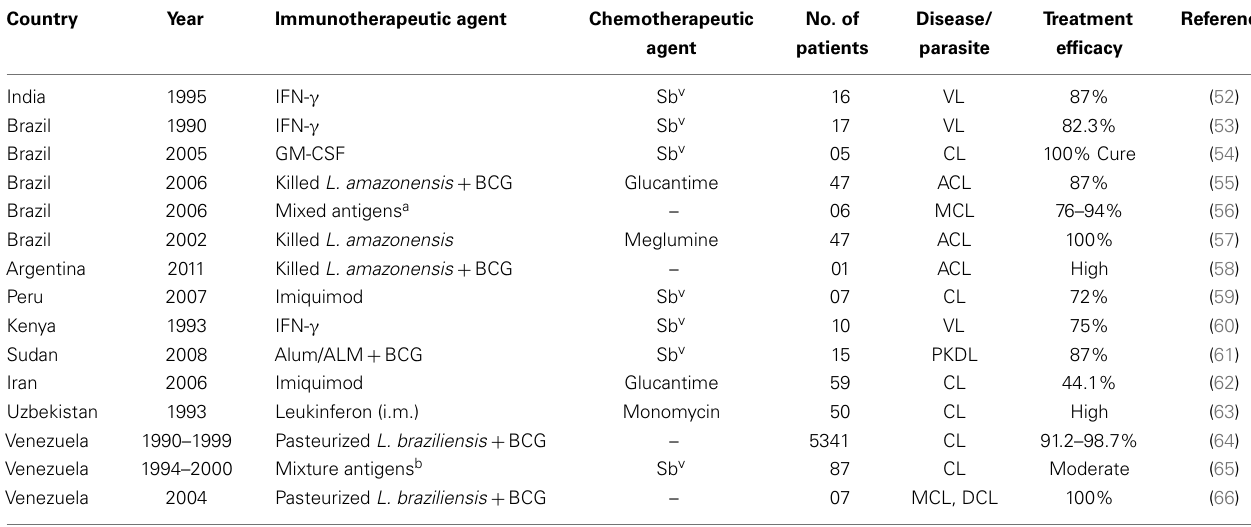
Table 2 | Immunotherapy of human leishmaniasis